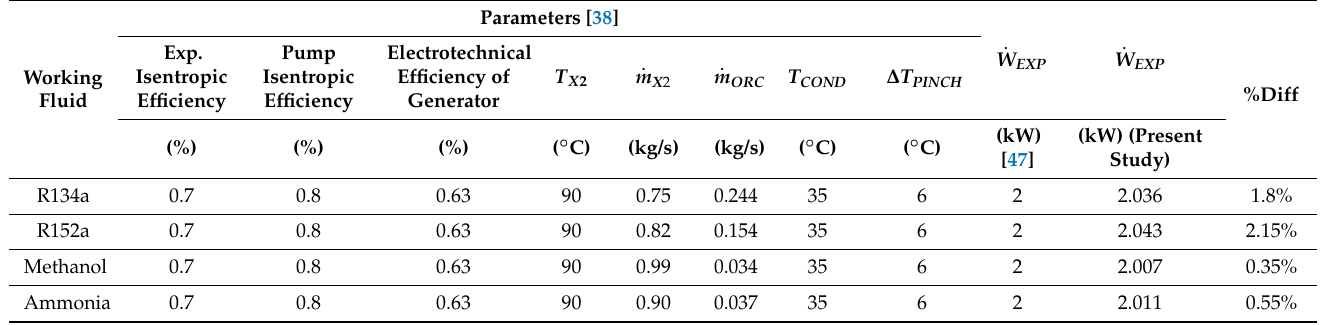
Table 5. Validation of the present simulation with Ref. [47], considering the conditions of Ref. [47].